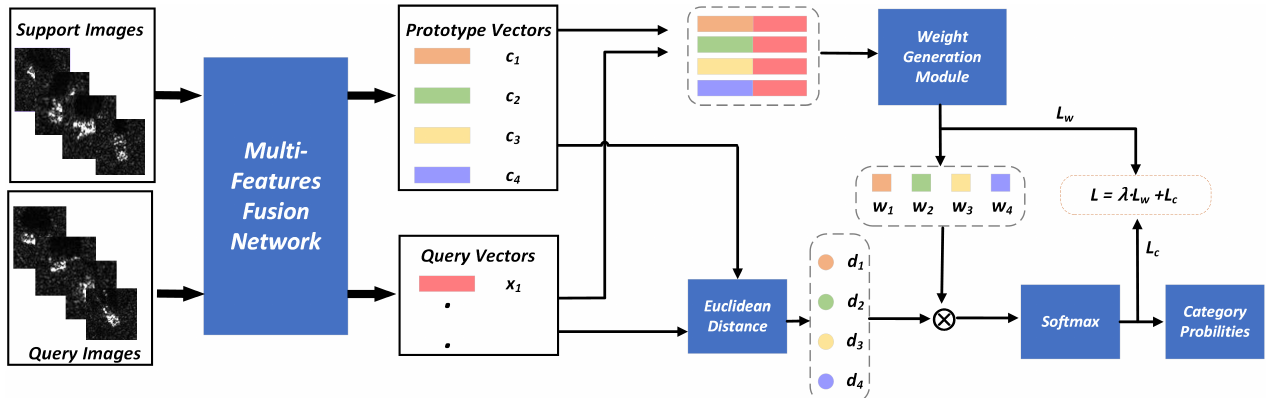
Figure 1. The framework of our proposed few-shot SAR image recognition method. The whole structure can be divided into two parts: the feature extraction network (MFFN) and the weighted Euclidean distance classifier. Support images are fed into the MFFN to extract features and then calculate the prototypes c 1 , c 2 , c 3 , c 4 by averaging. Query feature vector x 1 is extracted by MFFN to calculate the corresponding Euclidean distance d 1 , d 2 , d 3 , d 4 . Afterwards, x 1 is concatenated with the prototypes c i , and the concatenation vectors are sent to the weight generation module to calculate weights w 1 , w 2 , w 3 , w 4 . Finally, the weighted distances are obtained by multiplying weights with the Euclidean distance, and the softmax function is adopted to calculate the category probabilities on the weighted